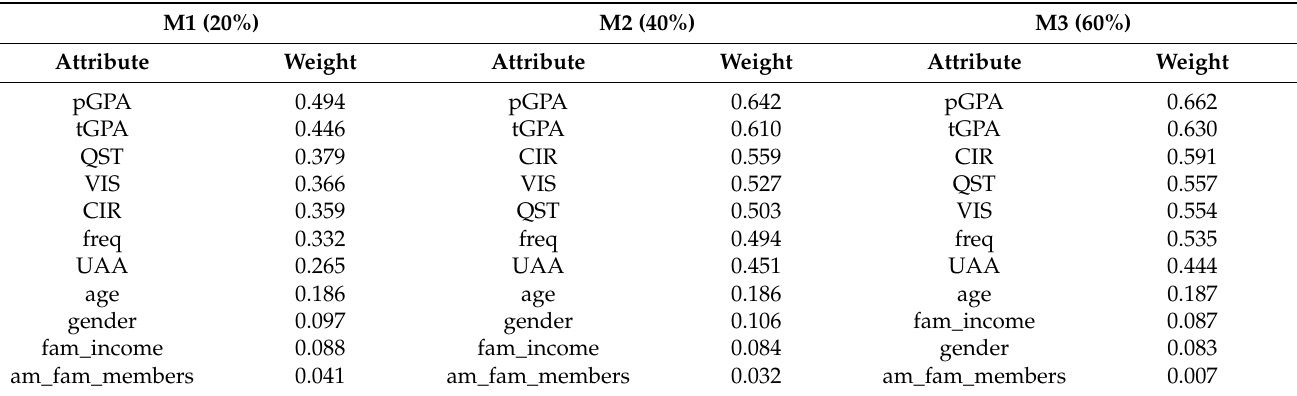
Table 5. Weights of attributes according to Pearson correlation: (a) at M1 (20%); (b) at M2 (40%); (c) at M3